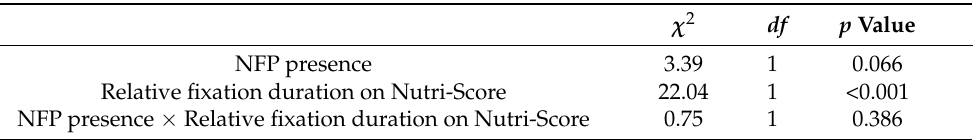
Table 6. The fixed part of the mixed-effects model with a random slope for NFP in the subset of participants exposed to products with Nutri-Score.